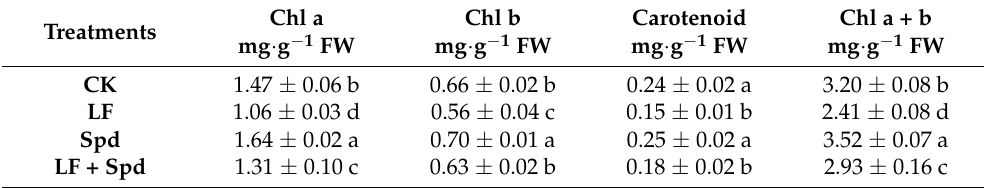
Table 3. Effects of exogenous Spd on chlorophyll content in tomato leaves under low-iron stress.